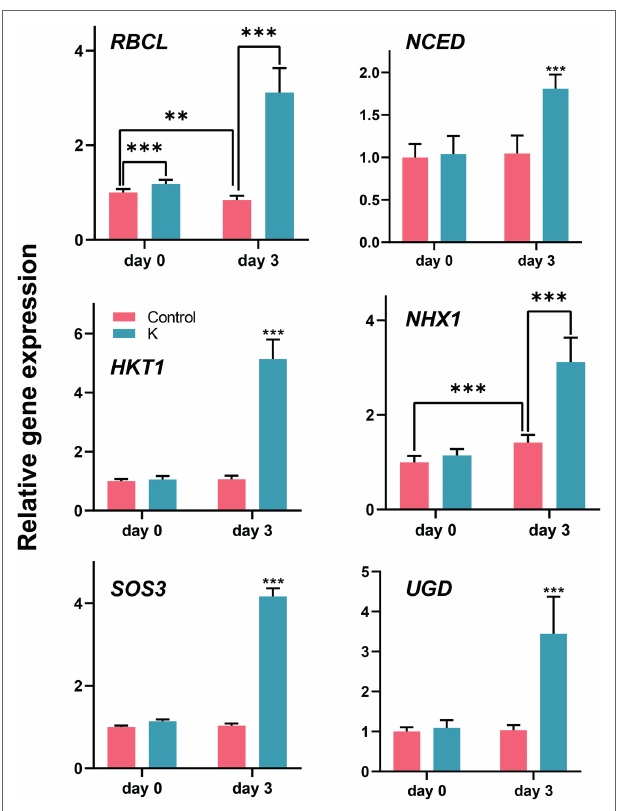
FIGURE 9 | Box plot showing changes of gene expression levels (fold differences) in maize under salt stress. The 14-day-old seedlings (seed bio- primed) were treated with 100 mM NaCl. After 72 h, leaves were collected and subjected to RNA isolation, followed by quantitative real-time reverse transcription-PCR. Asterisks represent values statistically different from the control at ** p < 0.01 and *** p < 0.001.